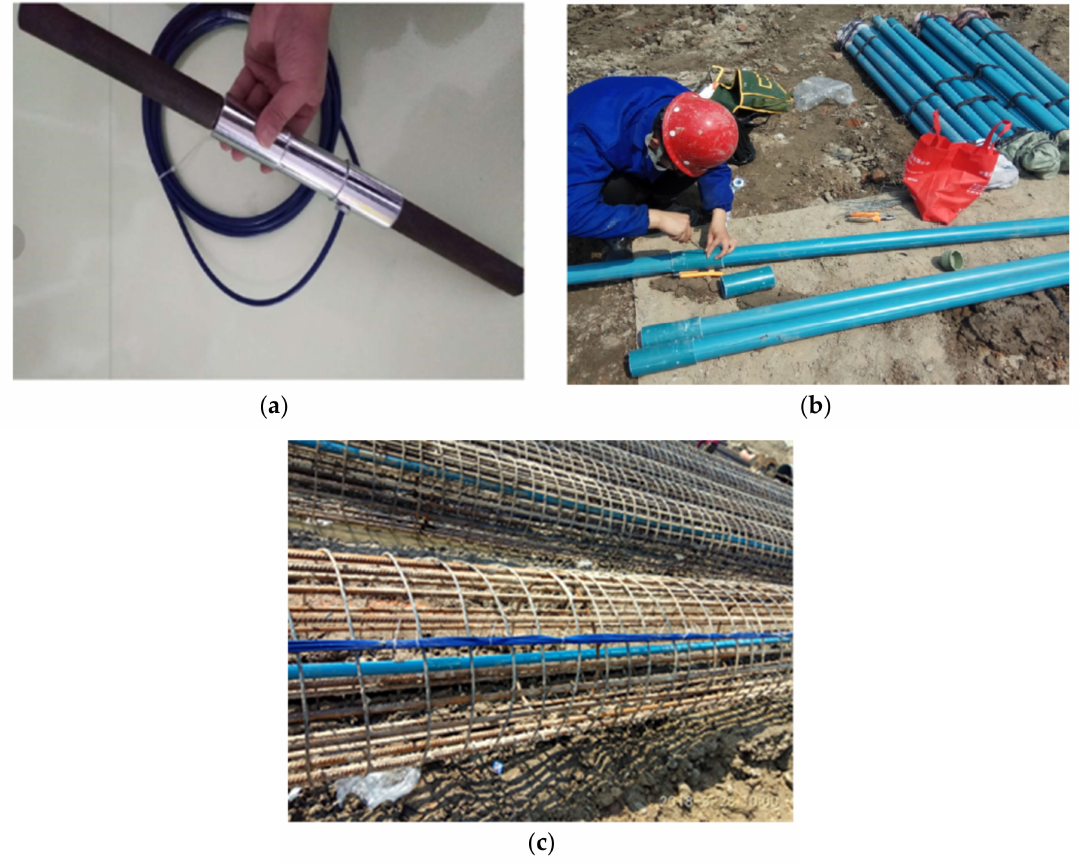
Figure 6. Site layout of stress gauge and inclinometer tube: ( a ) stress meter; ( b ) inclinometer tube. ( c ) reinforcement